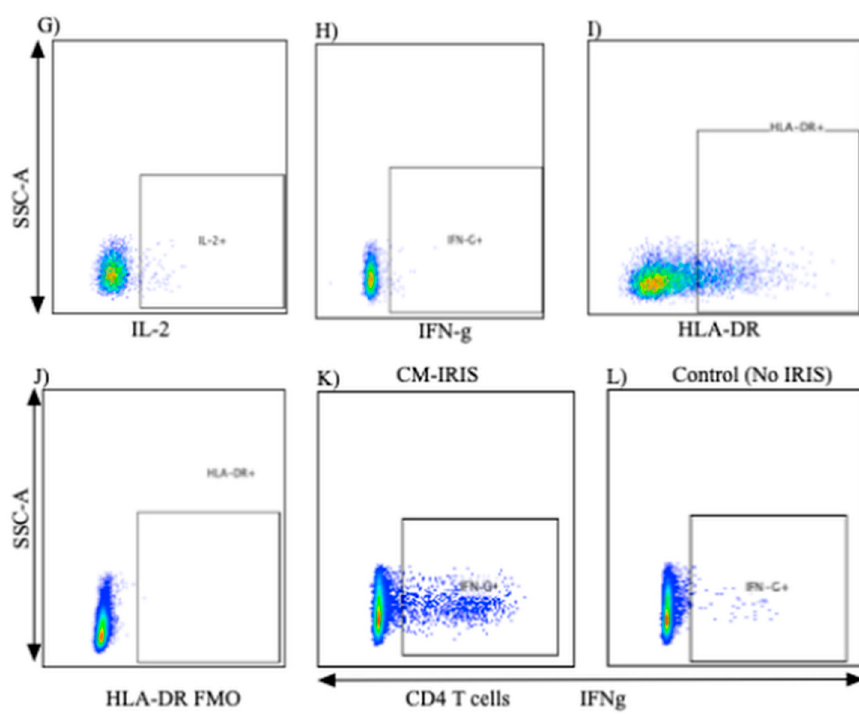
Figure 1. Flow cytometry gating strategy for T cells. Multiparameter flow cytometry was used to identify the frequency, phenotype, and post-stimulation cytokine expression of CD4 + and CD8 + T cells within total peripheral blood mononuclear cells of patients with and without CM-IRIS at baseline and at the CM-IRIS event. Representative staining shows the analytic gating strategy: ( A ) FSC-H / FSC-A showing the singlet gate; ( B ) FSC / SSC for lymphocytes selected from singlet gate; ( C ) T cells expressing CD3 were selected; ( D ) CD3 + cells expressing CD4 and CD8 were then identified; ( E ) gating by di ff erential expression of CD27 and CD45RO identified naïve and memory T cells subsets with naive T cells as (CD27 + CD45RO − ); central memory as (CD27 + CD45RO + ), e ff ector memory as (CD27 − CD45RO + ), and terminally di ff erentiated e ff ector memory as (CD27 − CD45RO − ); ( F ) CD4 + expression of IL-17 (unstimulated); ( G ) representative example of IL-2 expression by CD4 + T cells (unstimulated); ( H ) representative example of IFN- γ expression by CD4 + T cells (unstimulated); ( I ) representative example of HLA-DR expression by CD4 + T cells and; ( J ) HLA-DR Fluorescence minus one gating; ( K ) representative example of IFN- γ expression by CD4 + T cells in a subject with CM-IRIS and; ( L ) IFN- γ expression by CD4 + T cells in a control subject without